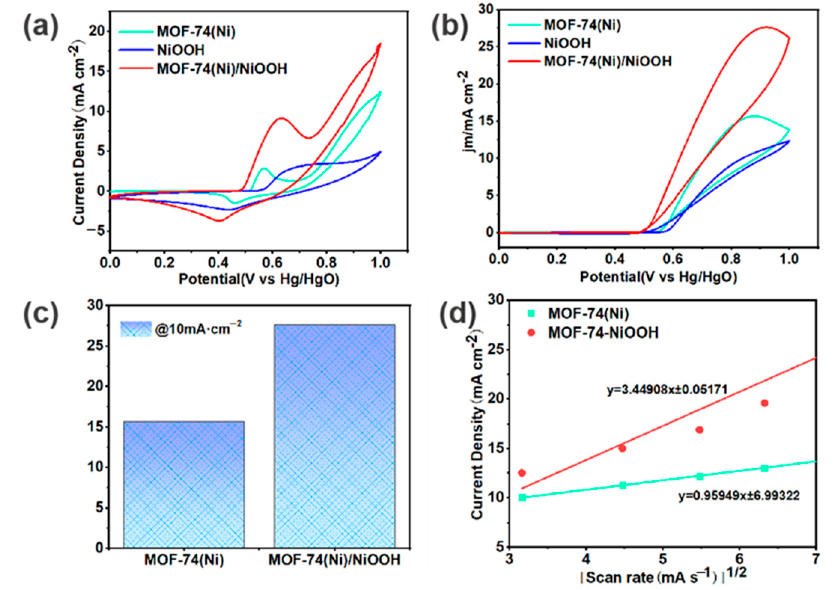
Figure 4. ( a ) Cyclic voltammetric responses of NiOOH, MOF-74(Ni), and MOF-74(Ni)/NiOOH catalysts. ( b ) MOR curves of different catalysts operated in 0.1 M KOH in the presence of 1.0 M CH 3 OH. ( c ) Comparison of peak current densities for different catalysts. ( d ) Linear relation between the current densities and square root of scan rates of MOF-74(Ni) and MOF-74(Ni)/NiOOH catalysts.